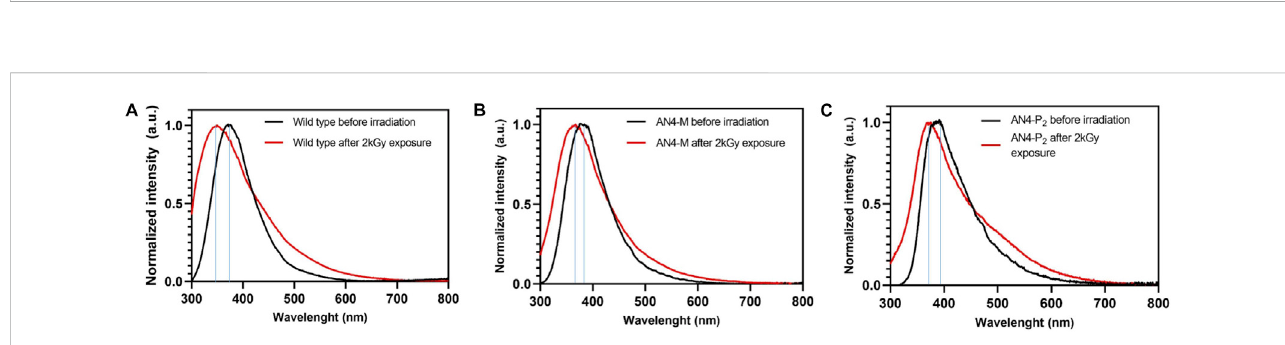
FIGURE 7 Photoluminescence emission spectra in normal conditions and after 2 kGy exposure of wild type (A) , AN4-M (B) , and AN4-P 2 (C)